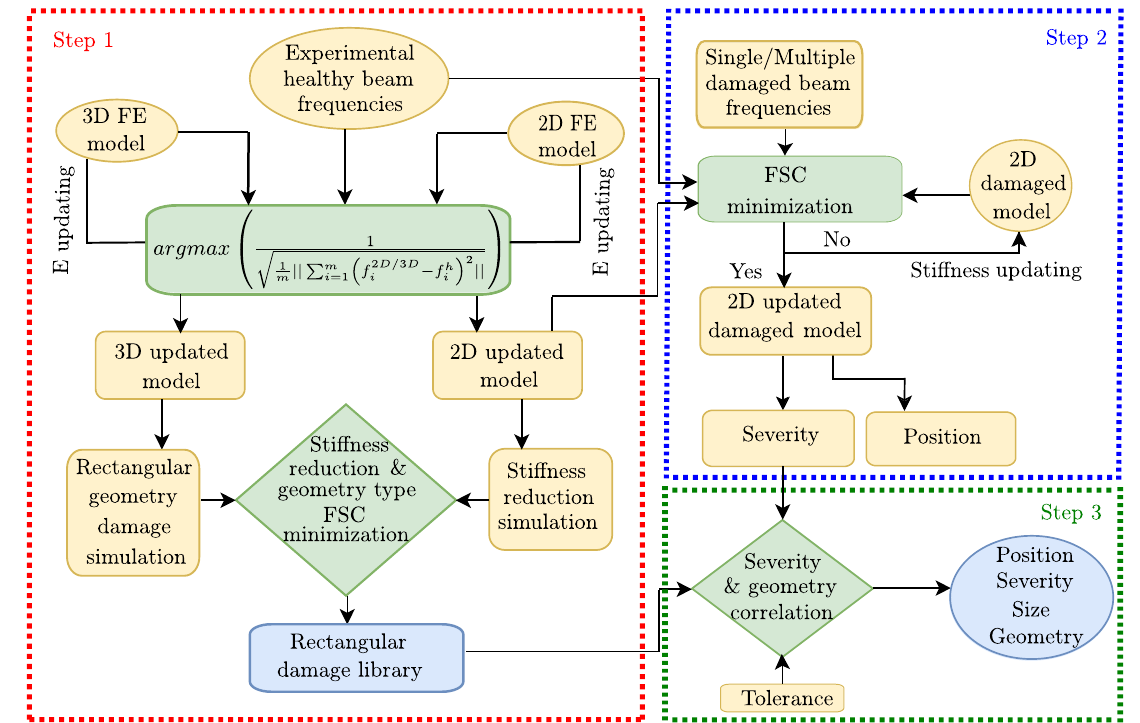
Figure 4. Flowchart of proposed strategy for geometry damage properties